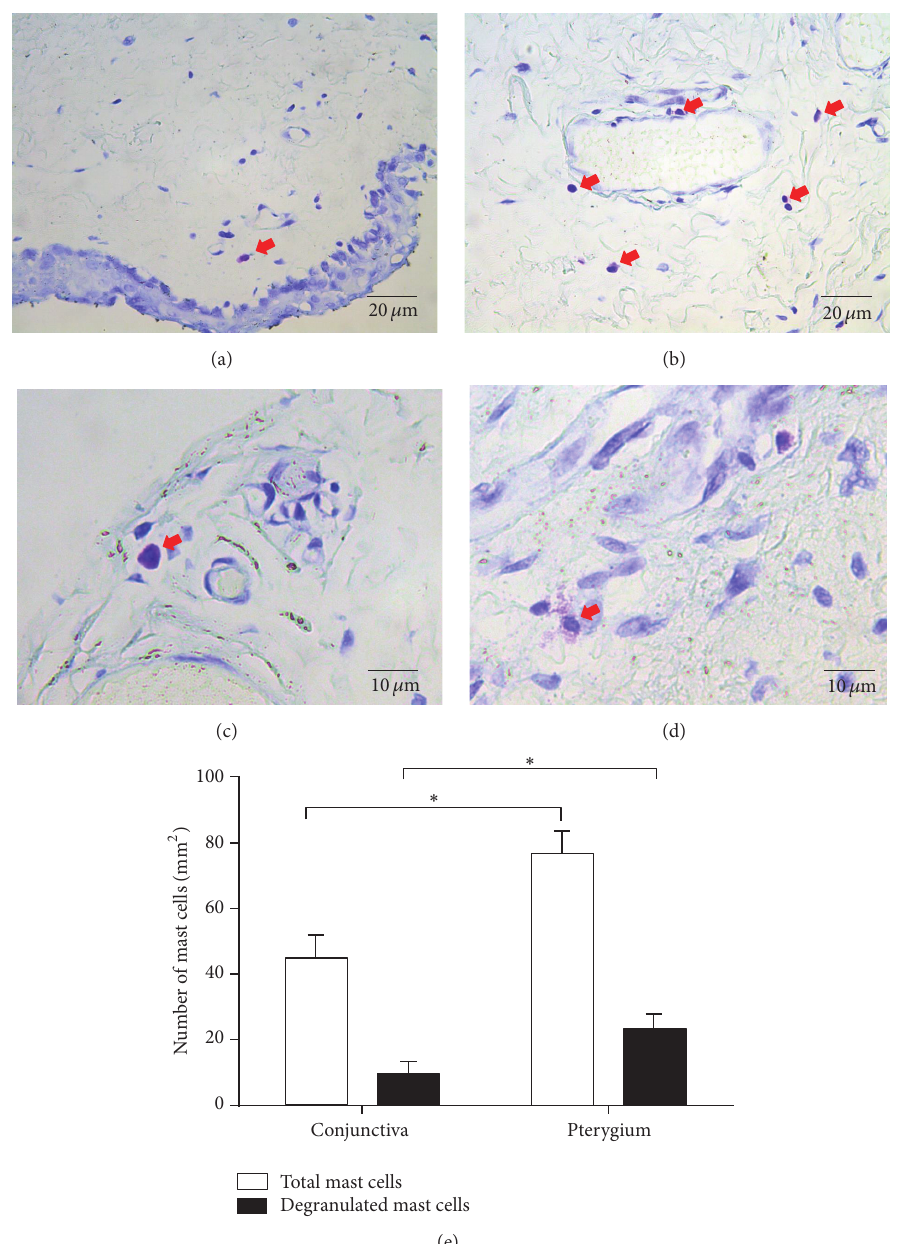
Figure2:Toluidinebluestainingofpterygiumandconjunctiva:mastcellsshowedthespecificvioletstaining.(a,b)Typicalphotosoftoluidine blue staining of mast cells in conjunctiva (a) and pterygium (b). (c, d) Typical photos of toluidine blue staining of intact mast cells